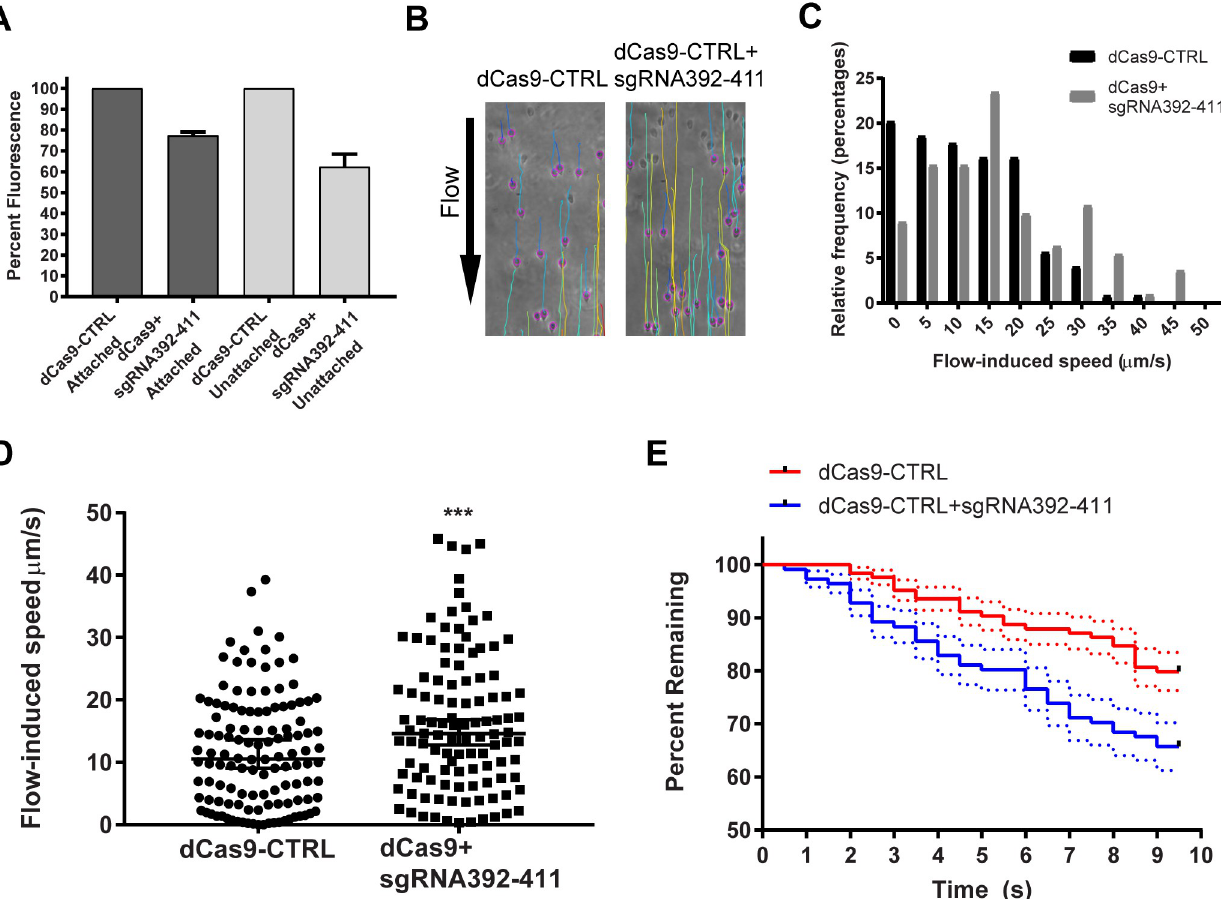
Fig 6. DAAP1 depletion results in reduced attachment. A) DAAP1 fluorescence levels from control (dCas9-CTRL) and DAAP1-depleted (dCas9 +sgRNA392-411). Unattached cells had a greater decrease in DAAP1 expression (38% ± 6) than attached cells (23% ± 2). Average of two independent transformations with three technical replicates for each is shown. B) In this flow chamber assay, attached cells were challenged with a flow rate of 100 μ L/ min. Cells were tracked for 10 seconds using TrackMate software in ImageJ, colored lines indicating resulting paths. C) Distribution of mean flow-induced speed. D) Mean flow-induced speed of each cell for 10 seconds after challenge, with median and 95% confidence intervals. A two-tailed Mann-Whitney test indicated that this difference was statistically significant, (N dCas9-CTRL = 124, N dCas9+sgRNA392-411 = 111), P = 0.001. Median of control = 10.56, upper 95% CI = 13.33, lower 95% CI = 10.15. Median of DAAP1-depleted is 14.62, upper 95% CI = 18.62, lower 95% CI = 14.41. E) Kaplan-Meier curve of cells displaced from the field of view over time, P = 0.0077 N = 124 for control, N = 111 for DAAP1-depleted cells. Median and standard error shown.